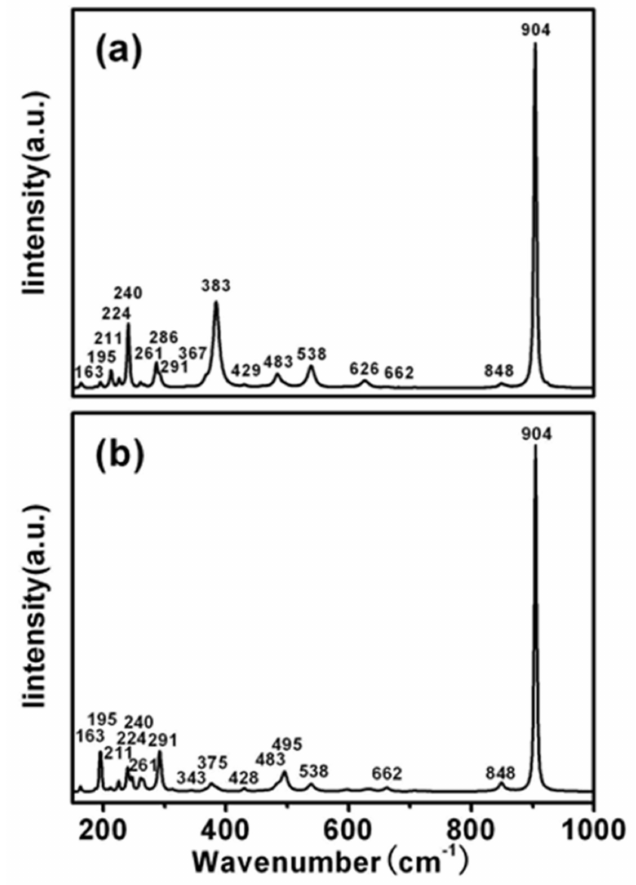
Figure 4. ( a ) Raman spectra on the cross-section and ( b ) the side face of the